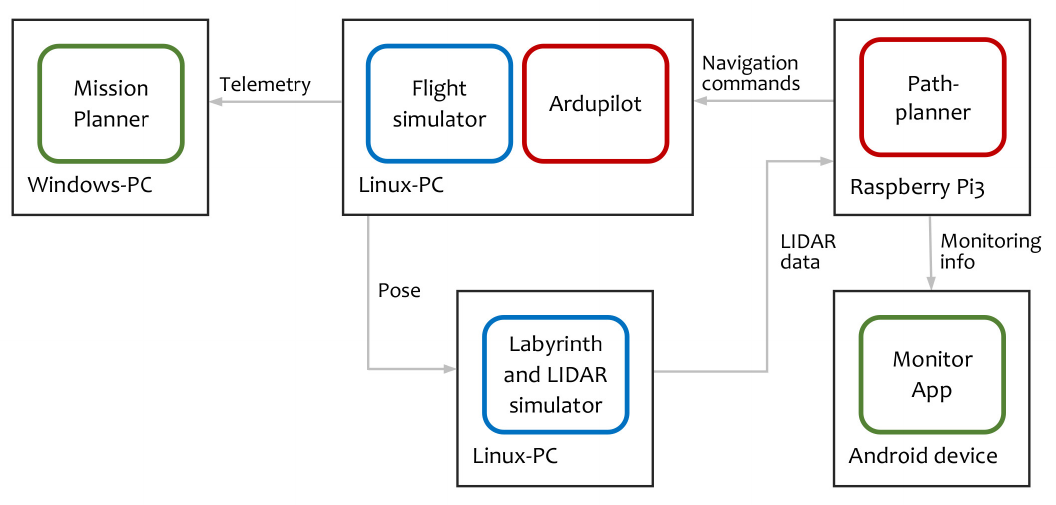
Figure 8. Hardware in the loop architecture. Red components are real unmanned aerial vehicle (UAV) software, blue components are simulators, and green components are monitoring